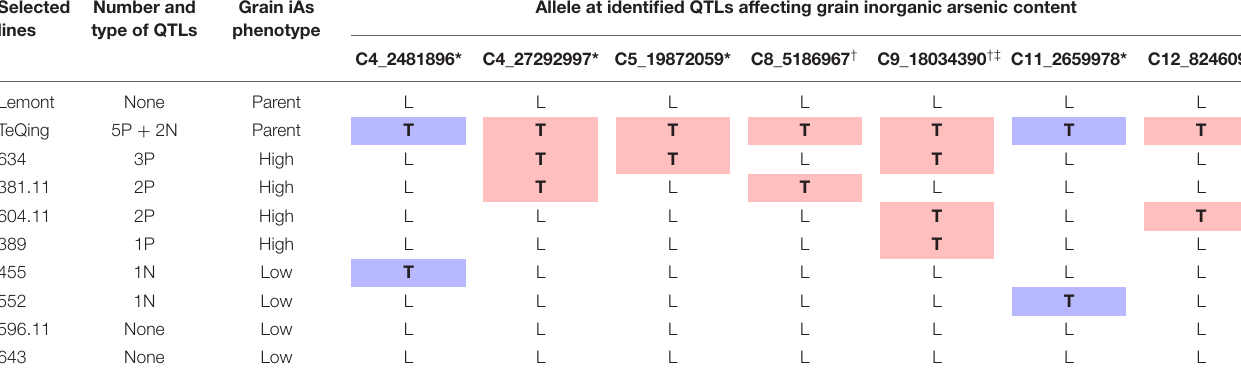
Datasets used to identify QTLs are denoted by symbols: † Flood 2013, ‡ Safe-AWD 2013, ∗ Flood 2014. The number and type of identified QTLs are shown for each line with the notation chromosome number, followed by position in bp (e.g., chromosome 8 position 5,186,967 bp is C8_5186967), with L and T representing Lemont or TeQing alleles. Letters P and N indicate the number of TeQing QTL introgressions that are either positively (P) or negatively (N) affecting grain iAs. Letters within a QTL column indicate the presence of the TeQing introgressed allele (T) or the Lemont recurrent parent allele (L). Red and blue highlights indicate the TeQing allele increases or decreases grain inorganic arsenic, respectively. No highlight indicates Lemont was the segment present in the identified QTL region.